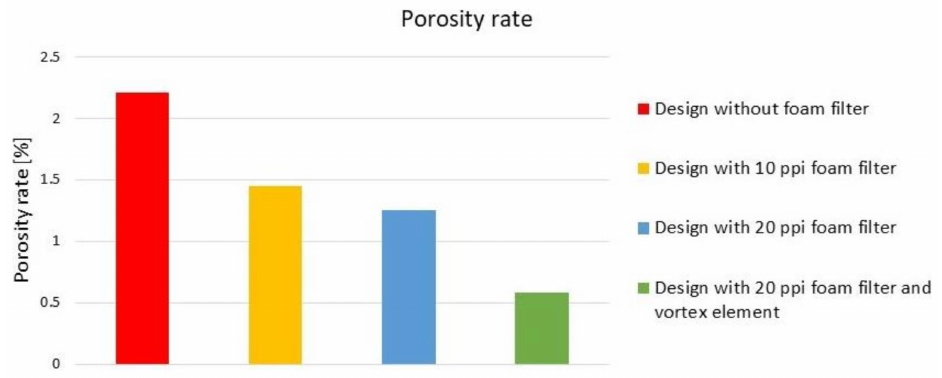
Figure 13. Results of porosity